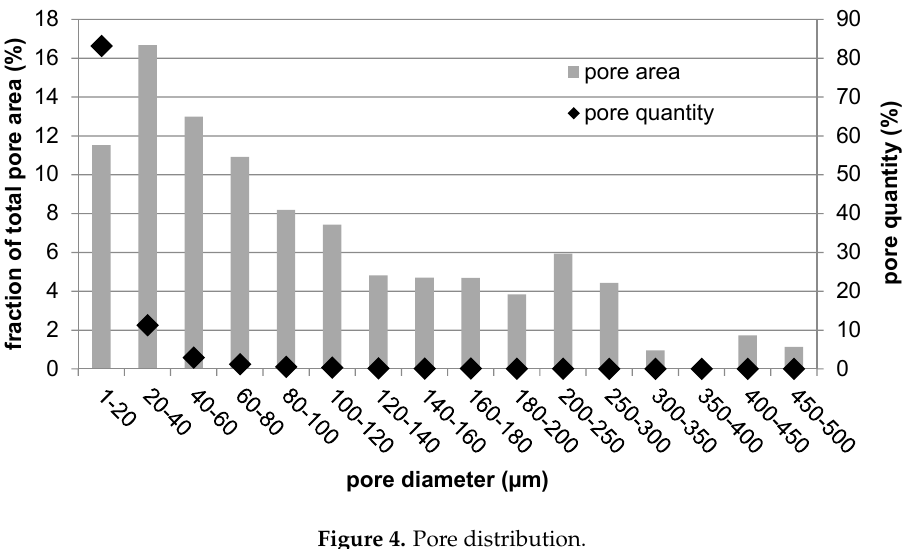
Figure 4. Pore distribution.